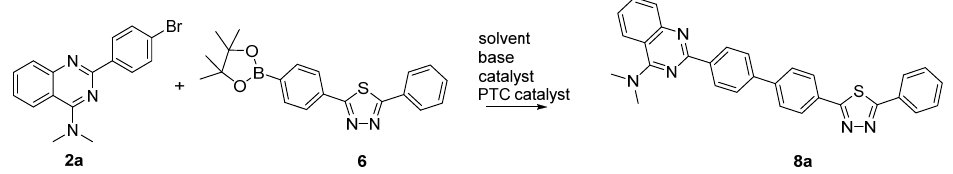
Table 1. Optimization of the Suzuki cross-coupling reaction to obtain 8a